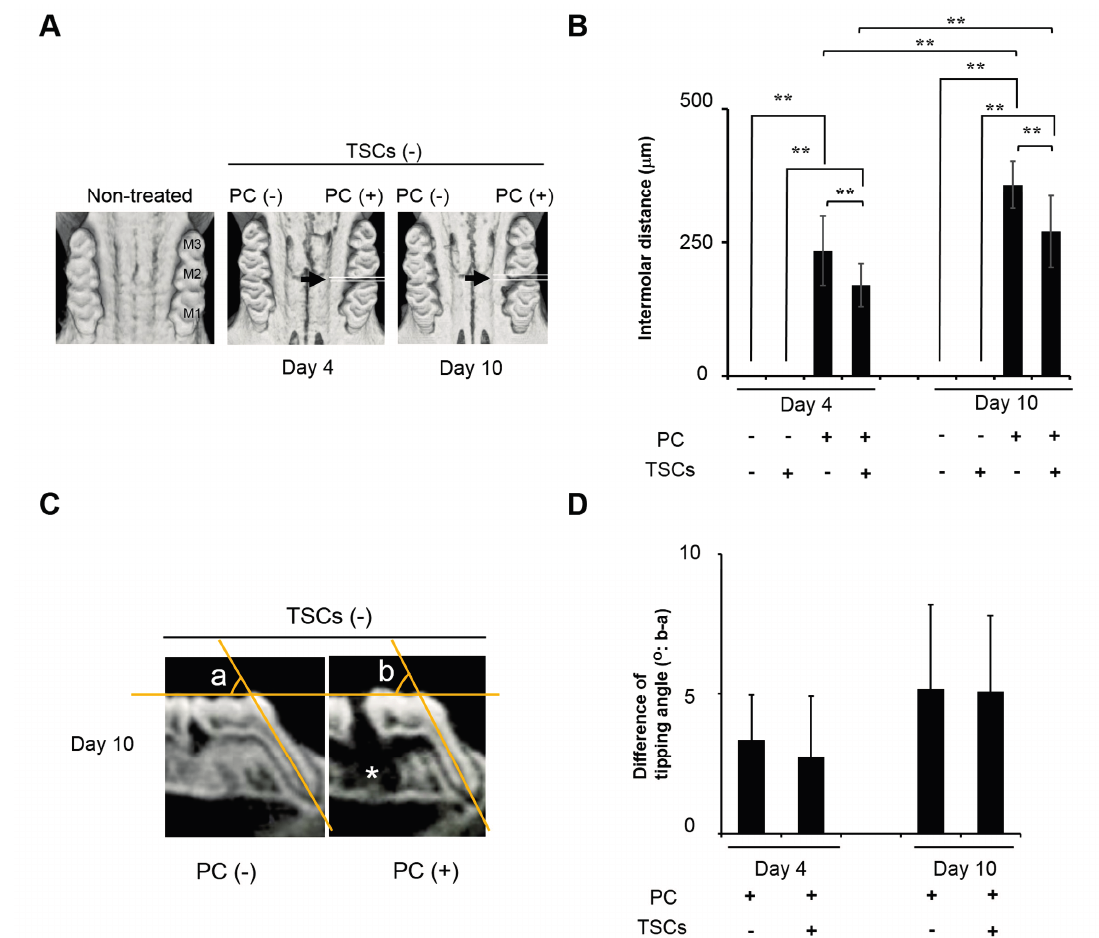
Figure 2. The comprehensive mixture of tobacco smoke components (TSCs) retarded experimental tooth movement. M1: first molar. M2: second molar. M3: third molar. PC: power chain. ( A , C ) μ CT images of the maxillary bone observed from occlusal and lateral views; ( A ) Black arrows represent the PC insertion site. PC time-dependently separated the molars; ( B ) Quantitative data on intermolar distances between M1 and M2. All data show mean ± s.d. ( n = 10). ** p < 0.01 (ANOVA with Tukey–Kramer test). TSCs significantly retarded experimental tooth movement induced by PC insertion; ( C ) Representative sagittal two-dimensional section of dentition with/without PC insertion. PC insertion caused slight tipping for M1. Angles a and b: representative tipping angles with/without tooth movement used in ( D ); Contralateral side was used as angle a. White asterisk: disappeared alveolar bone adjacent to the distal root of M1; ( D ) The quantitative difference in tipping angles of